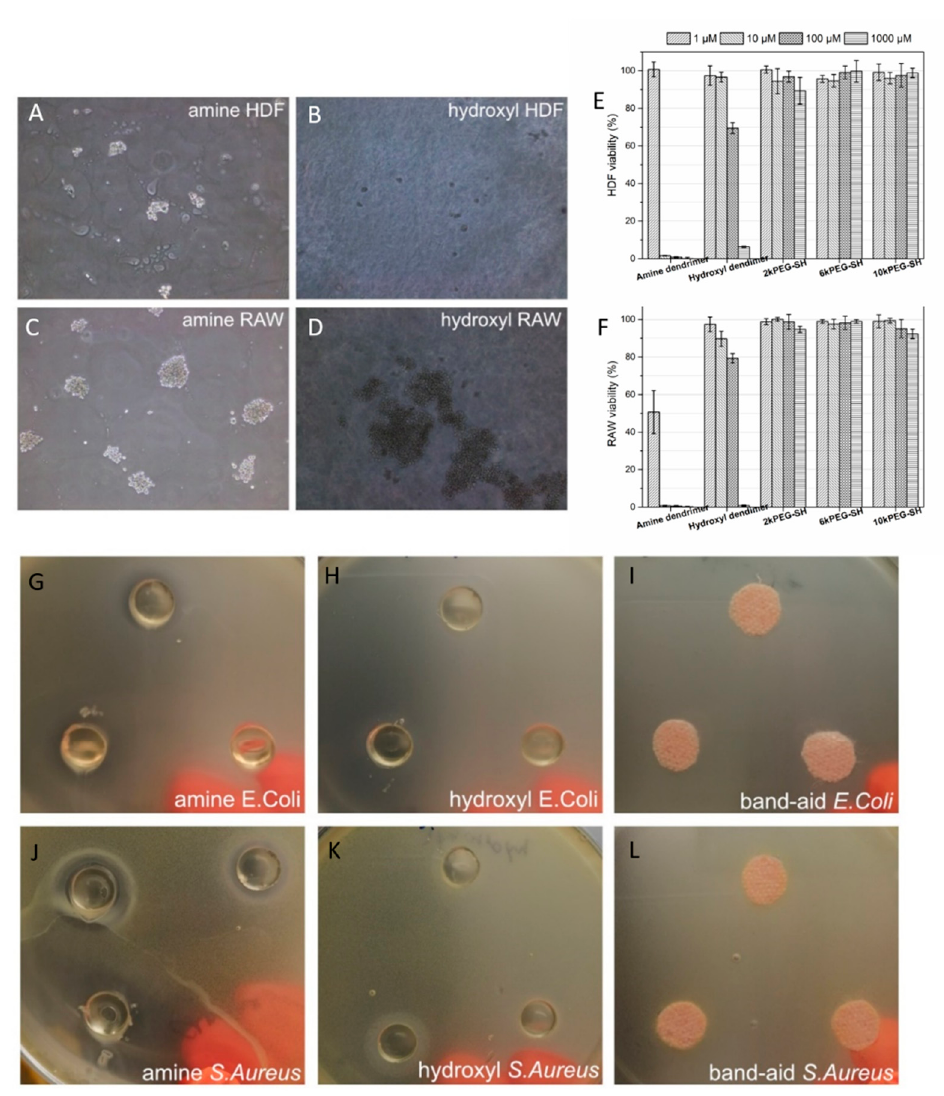
Figure 5. ( A – D ) The effects of gels on HDF and RAW 264.7 when cells were in direct contact with gels; ( E , F )) cytotoxicity of the dendrimers and thiol-terminated crosslinkers towards HDF and RAW 264.7 determined by Alarmarblue assay after 24 h incubation; and ( G – L )) antibacterial activity of the amine, hydroxyl gels and commercial band-aid against E. coli and S. aureus . The agar surrounding one of the gel samples in J was damaged, but inhibition zones are clearly visible around the other two amino-containing hydrogels in S. aureus .